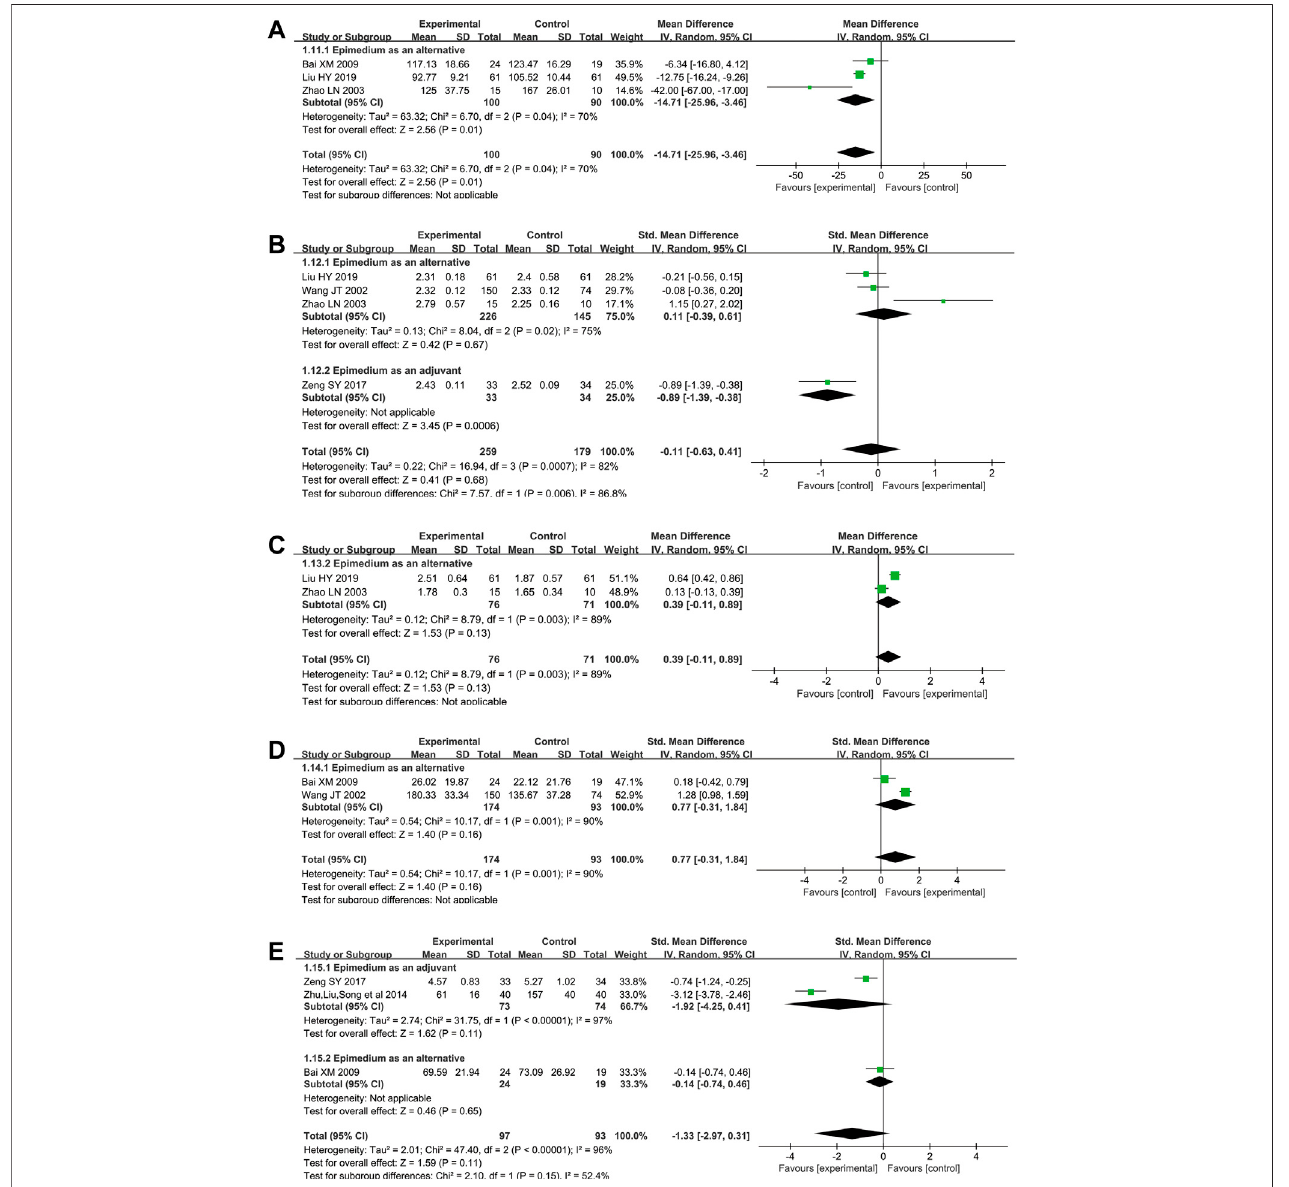
FIGURE 6 | Meta-analysis results of biochemical markers. (A) Alkaline phosphatase (B) Calcium ion (C) Phosphorus (D) Estradiol (E) IL-6.